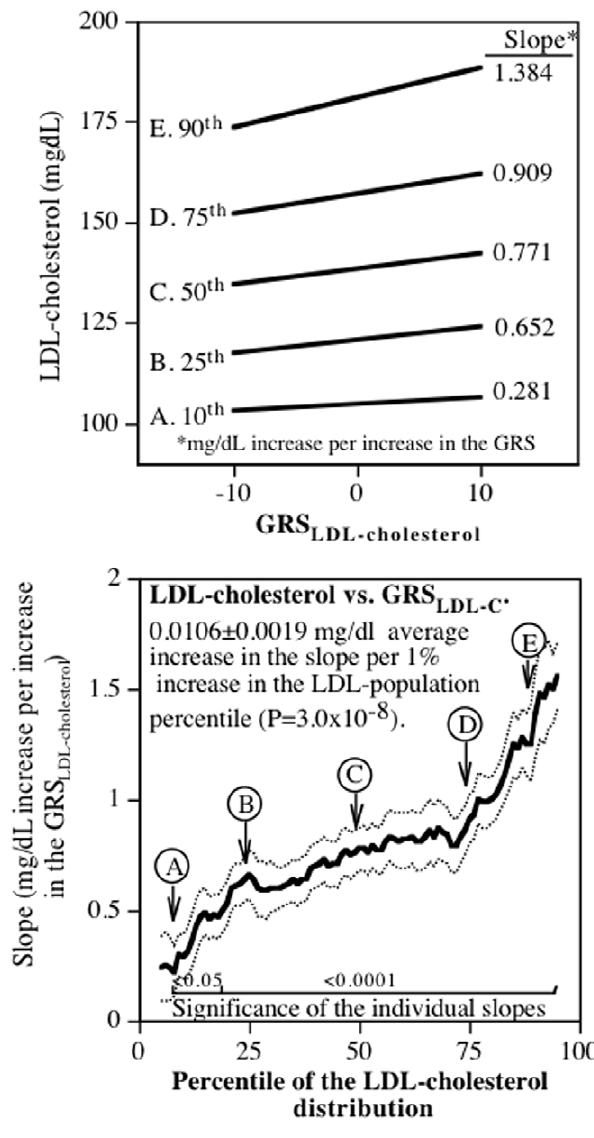
Figure 1. Increase in LDL-cholesterol per increase in the GRS LDL-cholesterol for selected percentiles (upper panel), and for all percentiles as a function of the LDL-percent distribution (lower panel). Note that the Y-axis represents LDL-cholesterol concentrations in the upper panel, and the slopes for LDL-cholesterol vs. GRS LDL-cholesterol in the lower panel. The correspondence between the upper and lower panels is illustrated by the letter designation of the corresponding slopes at the 10 th (A), 25 th (B), 50 th (C), 75 th (D), and 90 th (E) LDL-percentile distribution. Lighter lines designate 6 one standard error.